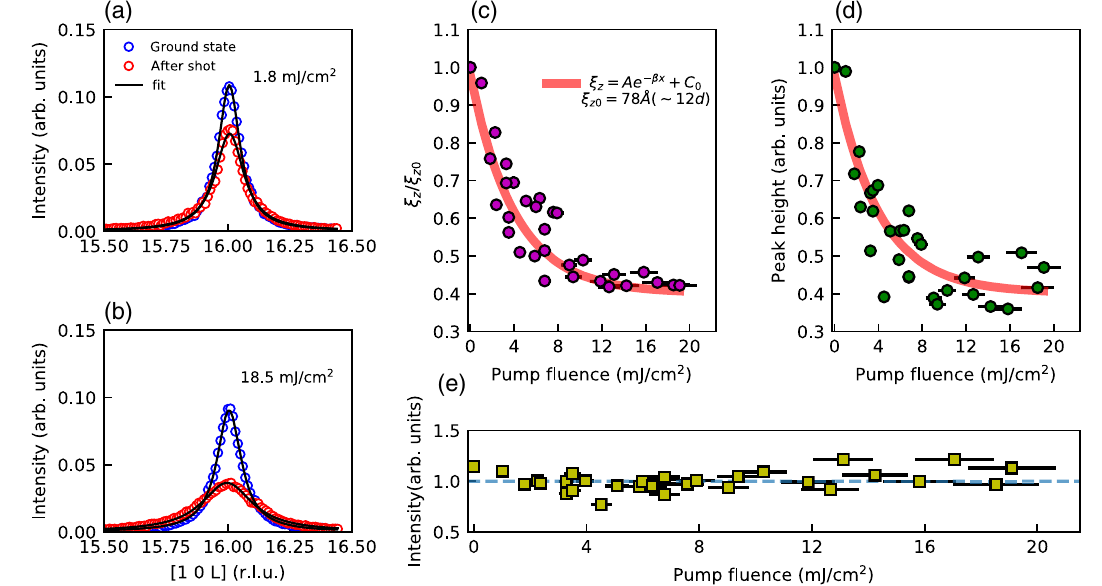
FIG. 3. Evolution of the interplane correlation as a function of the fluence. (a),(b) The fitting results for two representative conditions with weak and strong laser fluence. (c) – (e) The evolution of the interplane correlation length ξ z , peak height, and the integrated intensity as a function of the fluence, which are all normalized to the values before laser stimulation. With fluence higher than approximately 12 mJ = cm 2 , ξ z saturates to approximately five-layer thickness. The exponential lines are guides to the eye. The error bar for fluence is estimated to be 10% (see Supplemental Material